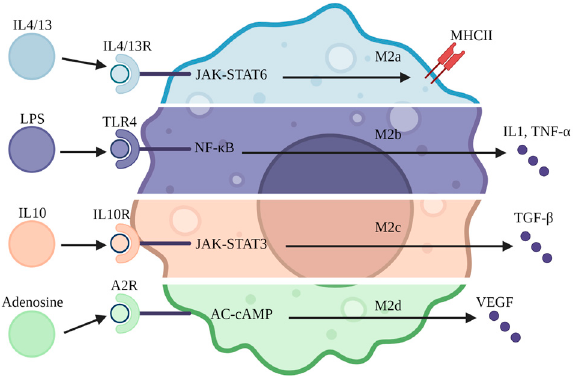
Figure 3. Different types of M2 macrophages. M2 macrophages can be divided into four types: M2a, stimulated by IL-4 and IL-13, can express more major histocompatibility complex II (MHCII) and has the function of antigen presentation; M2b, when stimulated by LPS, can express more IL-1 β and TNF- α , which is more similar to pro-inflammatory macrophages; M2c, which is stimulated by IL-10 to produce more transforming growth factor beta (TGF- β ) and is more consistent with the traditional view of anti-inflammatory macrophages; and M2d, which receives the action of adenosine, mainly produces vascular endothelial growth factor (VEGF) and may play a role in angiogenesis and circulation.